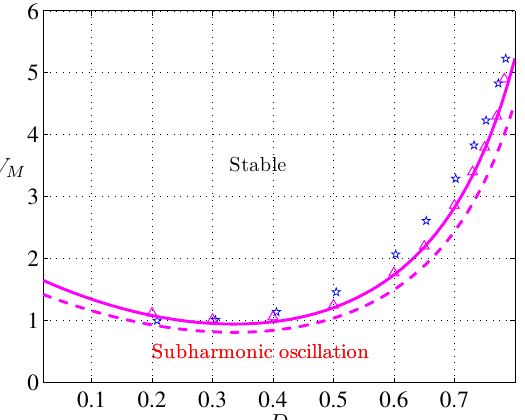
Figure 15. The stability boundary in the ( D , V M ) parameter space from the theoretical expression (41) by using fixed values of the inductances L ∗ inductances L 1 and L 2 values according to (42) (solid curve and